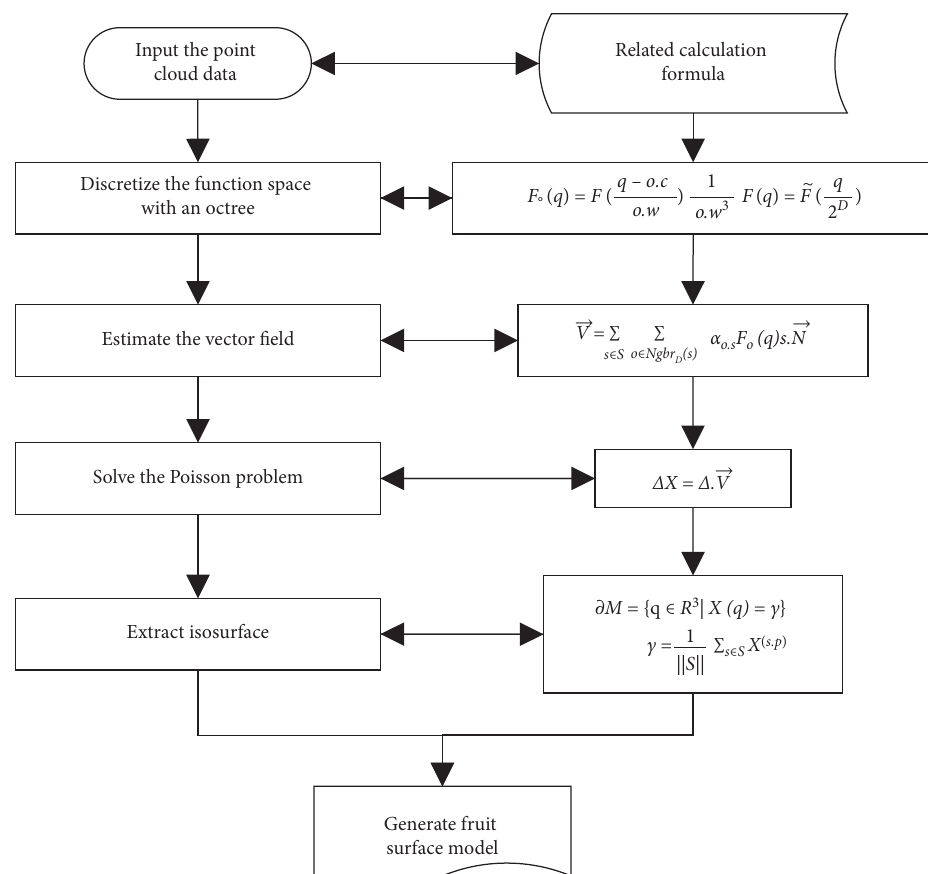
Figure 5: Flowchart of the Poisson reconstruction